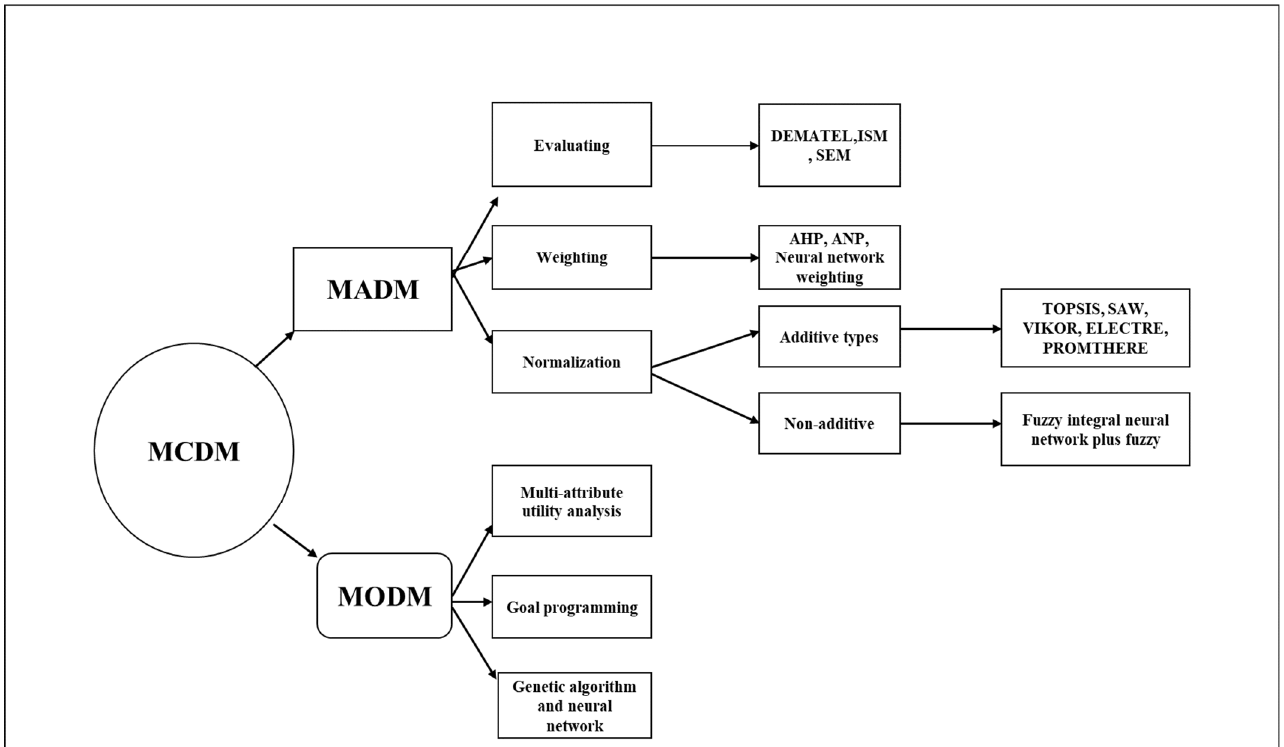
Figure 2. MCDM classification split between MADM and MODM.